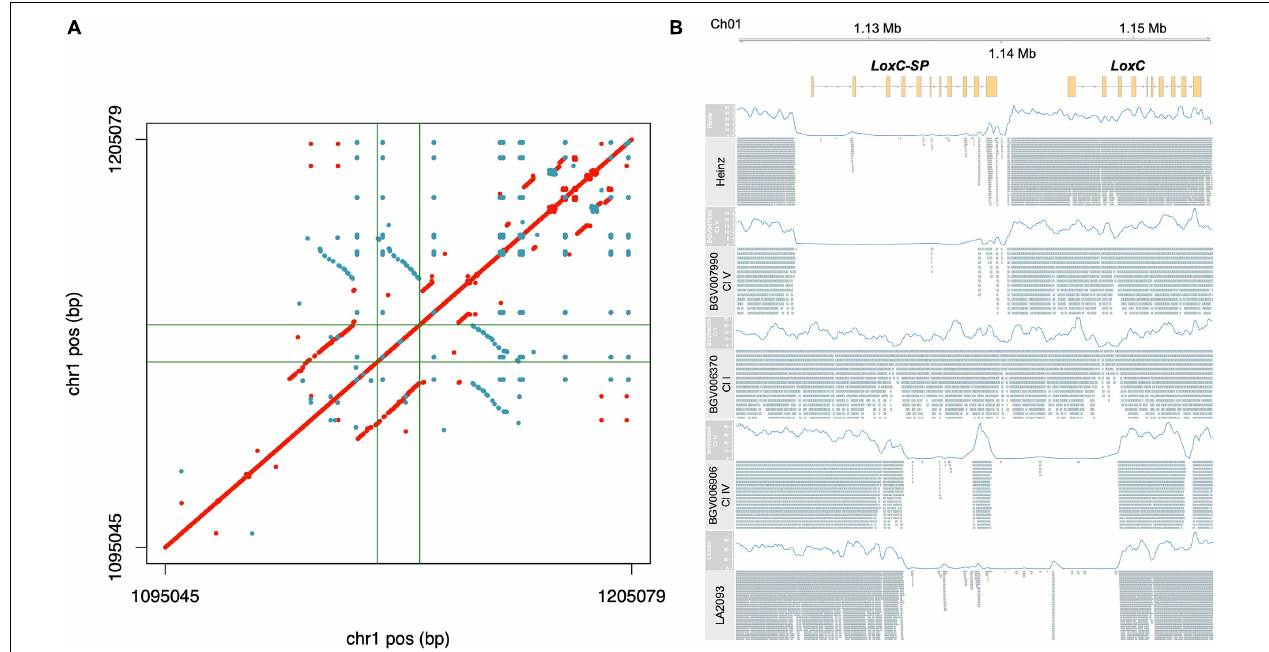
FIGURE 6 | Characterization of the duplication in LoxC locus. (A) Dotplot resulting the pairwise comparison of LoxC ± 50 kb in the assembly PAS014479_MAS1.0. Each dot corresponds to an identical match of 50 bp, red in the positive strand and blue in the reverse strand. The gene coordinates are delimited by green lines. (B) Alignment of five representative accessions against the PAS014479_MAS1.0 assembly at LoxC locus, including the coverage data (blue line) and the Illumina